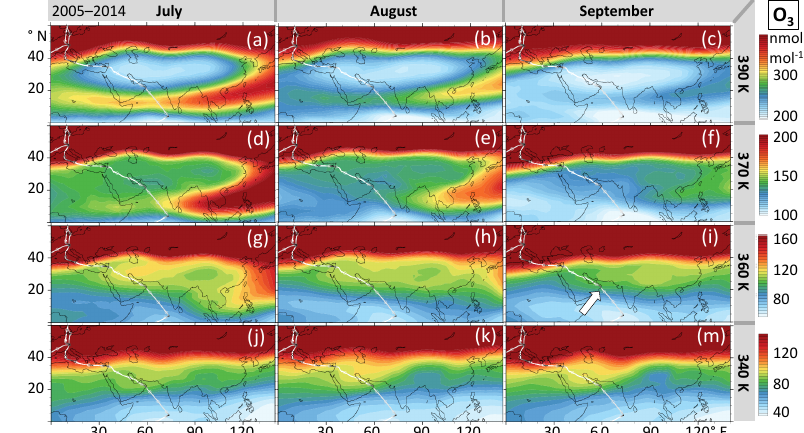
Figure 1. EMAC-simulated O 3 at different isentropic surfaces. Multi-annual monthly averages are calculated for the same period as in Santee et al. (2017) and agree well with their figures (370 and 390K). However, at the level corresponding to the HALO flight altitude (360K), O 3 is enhanced in the ASMA in September (i) and the observed sudden increase at the southern ASMA edge over Oman is also reproduced